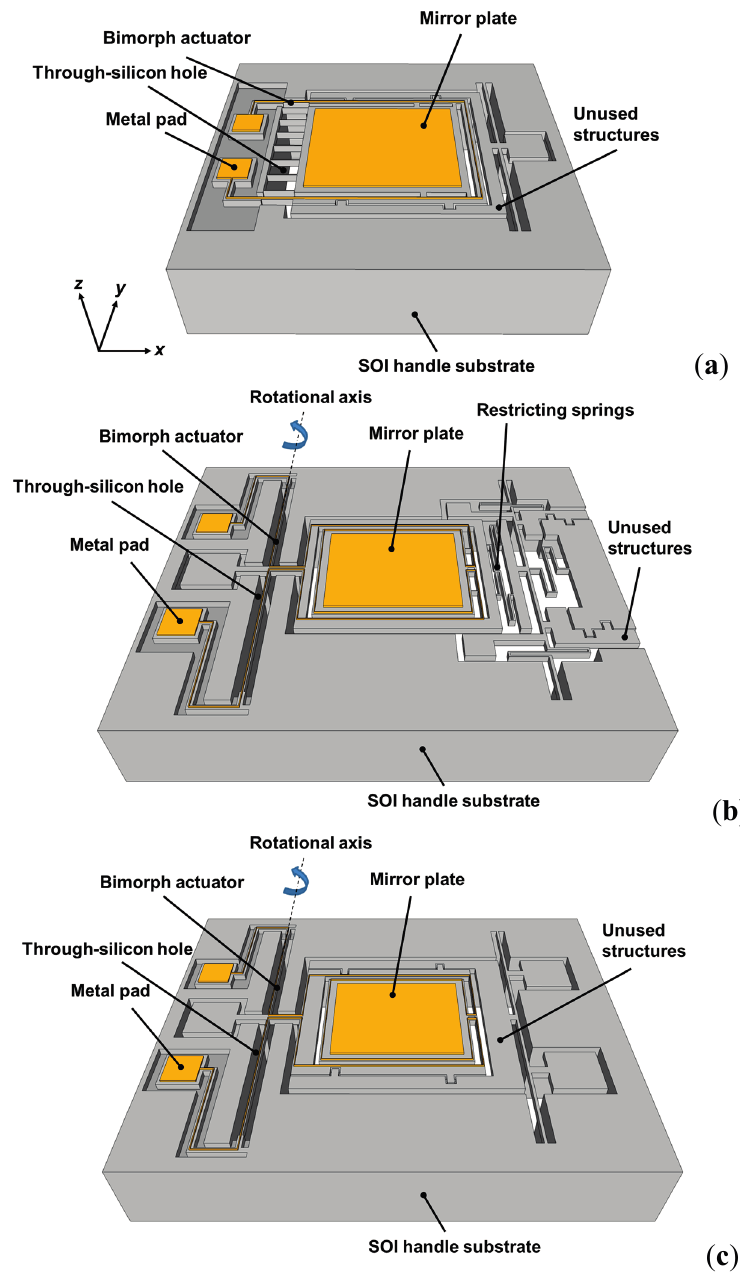
Figure 1. The 3-D schematic drawings of the ( a ) bending-type, ( b ) restricted-torsion-type and ( c ) free-torsion-type electrothermally-actuated micro-electro-mechanical systems (MEMS) mirrors. For simplicity, buried oxide is not